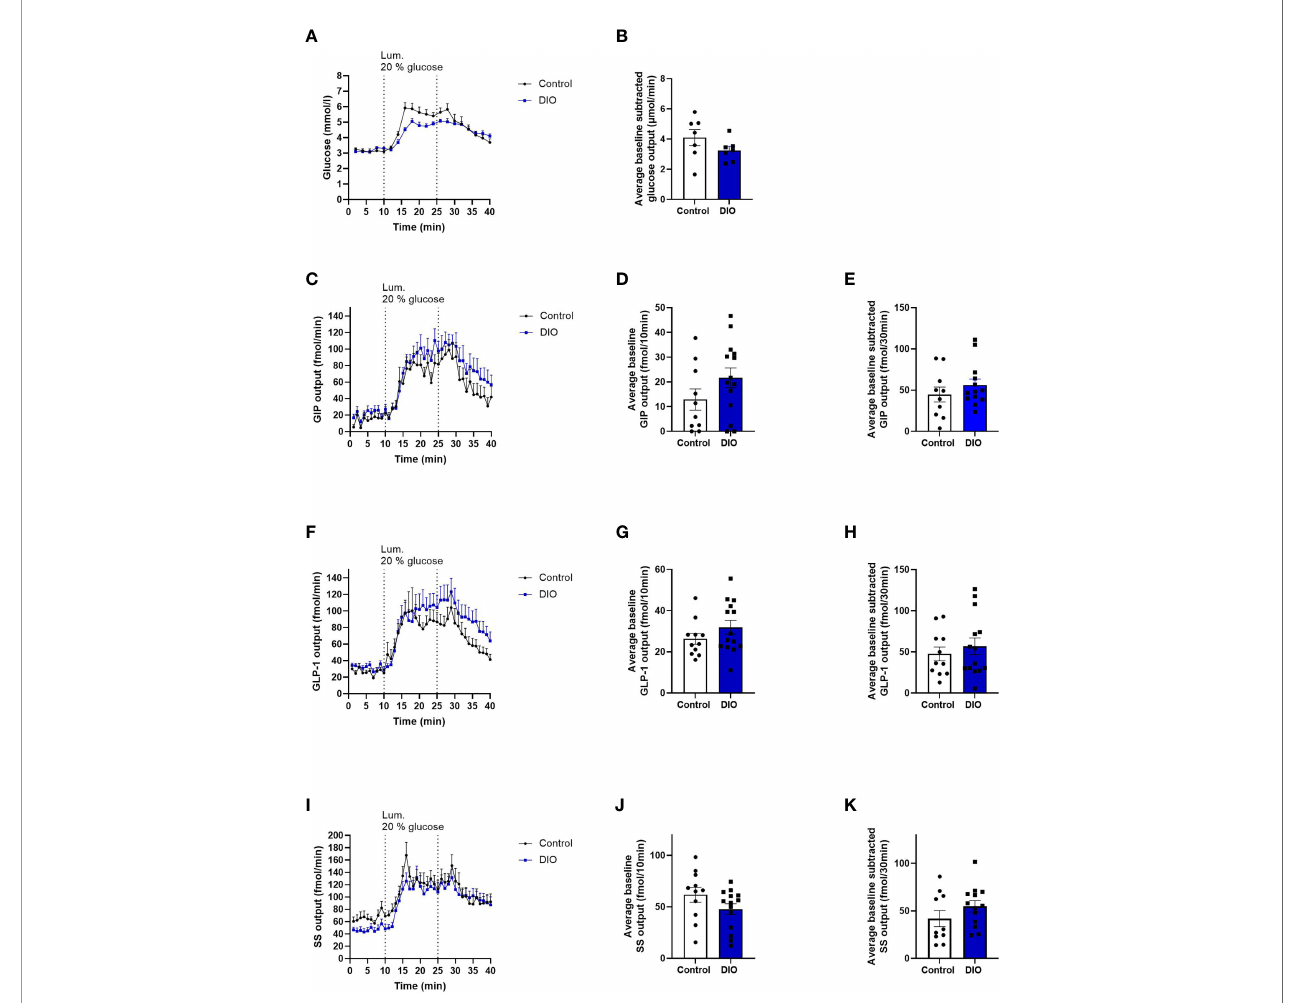
FIGURE 3 | Absorption of glucose and secretion of GIP, GLP-1, and SS are the same in isolated perfused proximal small intestines from control and DIO mice. (A) Glucose concentration (mmol/L) measured in the venous ef fl uents from control mice (black line, n = 7) or DIO mice (blue line, n = 7). (B) Average baseline subtracted glucose output (absorption) from 11 to 40 min in control mice (white box) and DIO mice (blue box) (C, F, I) GIP, GLP-1, and SS output in the venous ef fl uent in control mice (black line, n = 10 – 11) and DIO mice (blue line, n = 14) in response to 20% luminal glucose infusion. (D, G, J) Average baseline GIP, GLP-1, and SS output from 1 to 10 min in control mice (white box) and DIO mice (blue box). (E, H, K) Average baseline-subtracted GIP, GLP-1, and SS output during 20% luminal glucose infusion from 11 to 40 min in control mice (white box) and DIO mice (blue box). Each dot represents outputs from each experiment. Data are presented as mean ± SEM, and statistical signi fi cance was evaluated by a two-sided, unpaired Student ’ s